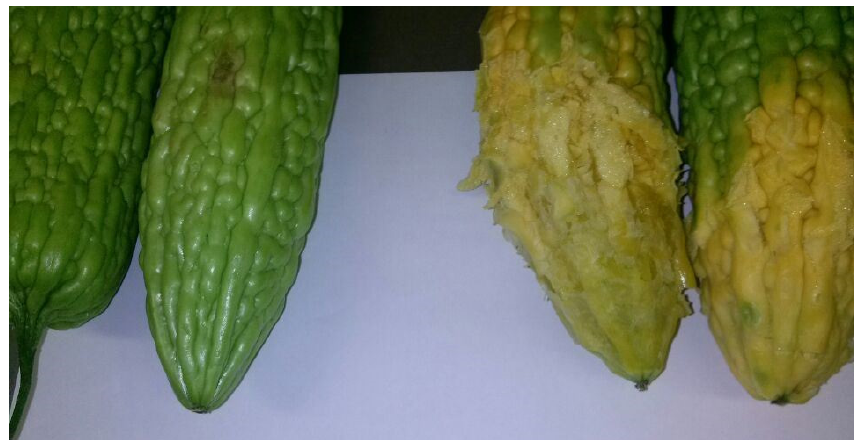
Figure 3. Appearance of bitter melon after storage for three days at 30 °C in the presence of ethylene at 0.001 µL L − 1 (left) and 1.0 µL L − 1 (right). Photograph supplied by Li and Wills [40]. For comparison, Wills et al. [38] also stored produce at the commonly accepted ambient temperature in temperate regions of 20 ◦ C in the same range of ethylene concentrations.